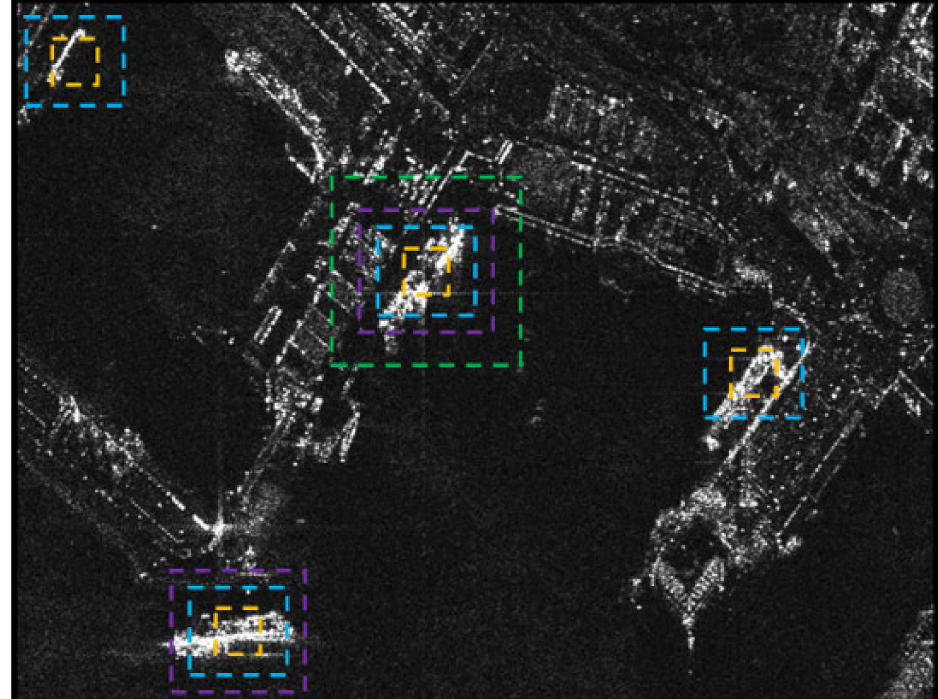
Figure 4. Multi-scale representations are critical for the detection and segmentation of marine ships in SAR images. The dashed boxes of different colors represent the extraction of features at different scales. These multi-scale representations can capture ship size, shape, and the background contexture, which are important information for ship detection and